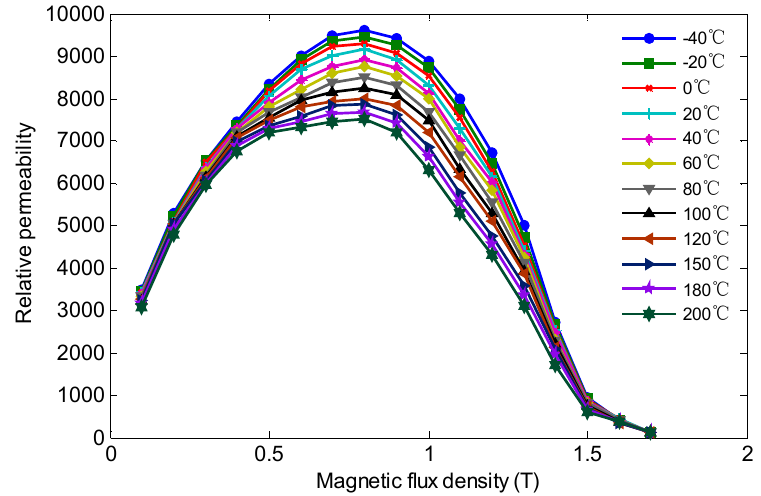
Figure 6. The curve of relative permeability with magnetic flux density in silicon steel.